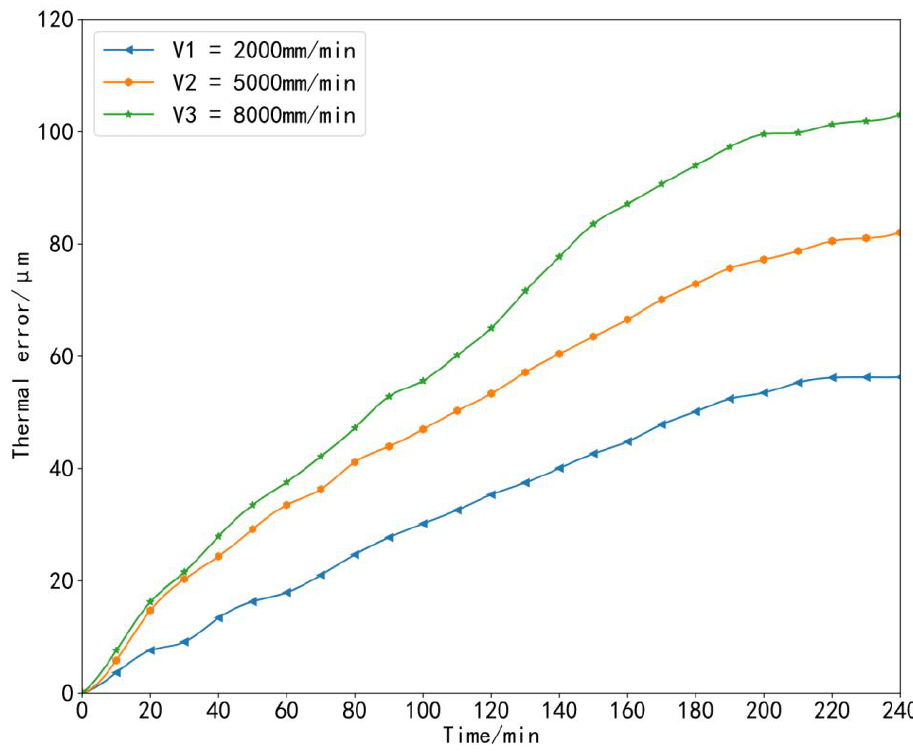
Figure 12. Thermal error data curves at three speeds.